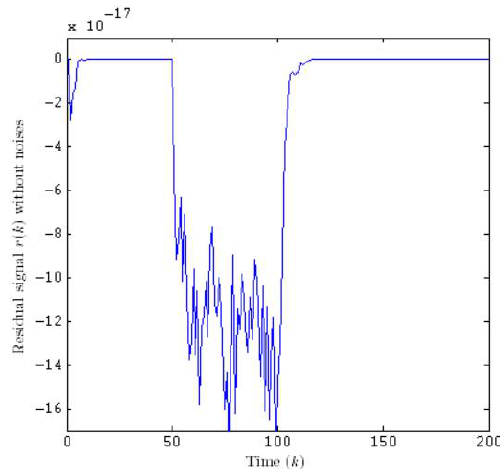
Figure 5. Residual signal without noises.